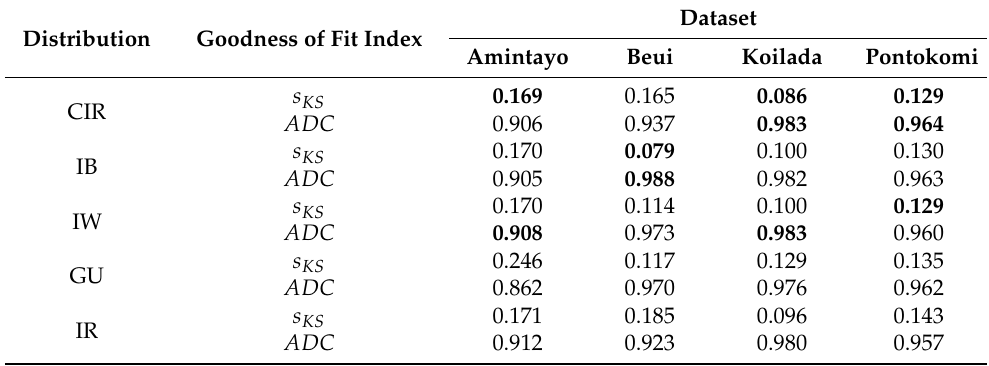
Table 3. Goodness of fit of the CIR distribution and of the benchmark distributions on the PM EWS datasets. Bold values indicate the best results for each